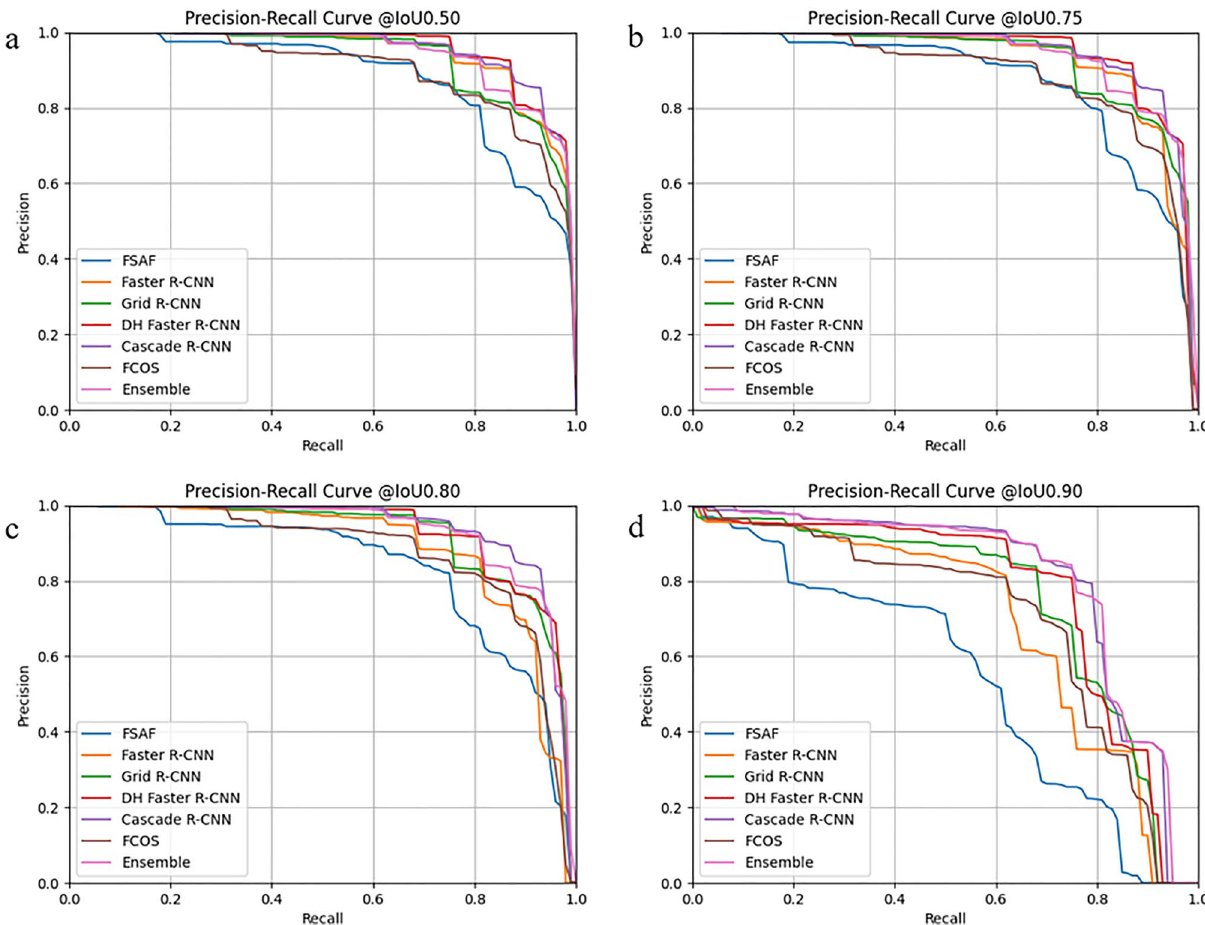
Figure 4. The PR curve of each model at different IoU. Performance comparison of the six models and ensemble model on test sets. The x-axis represents the recall values, and the y-axis represents the